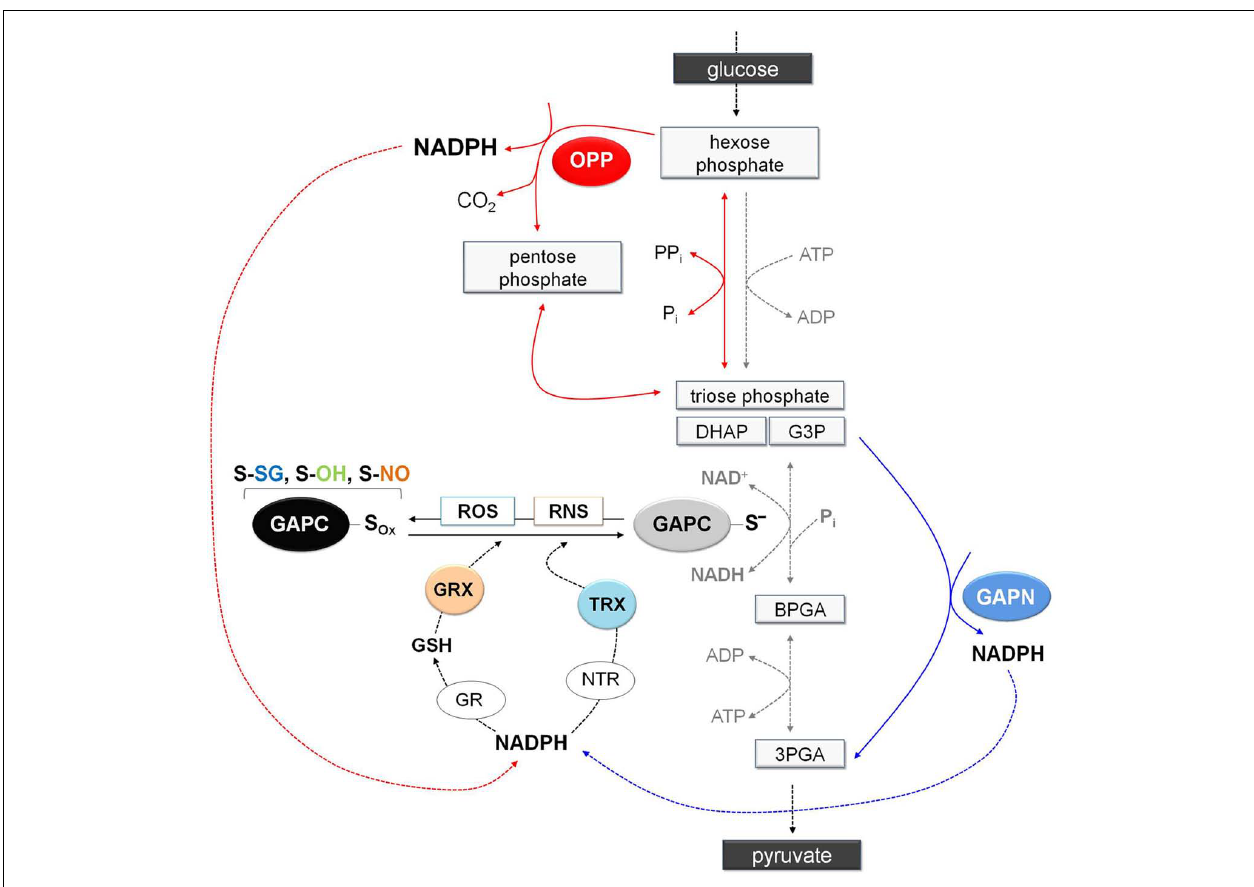
FIGURE 7 | Schematic representation of glycolysis showing the NADPH-producing systems in a situation of oxidative modification of GAPC. Under stress conditions, GAPC might undergo different type of oxidative modifications (GAPC-S ox : sulfenation, S-OH; glutathionylation, S-SG; or nitrosylation, S-NO) with important effects on cytoplasmic primary metabolism. Indeed, inhibition of GAPC activity and the consequent down-regulation of glycolysis pathway would promote entry of glucose equivalents into the OPP pathway leading to the generation of NADPH (red arrows). Although inhibition of GAPC would down-regulate the glycolytic pathway, plant cells also contain a non-phosphorylating GAPDH (GAPN) that can by-pass the GAPC-catalyzed reaction providing an alternative source of NADPH for the antioxidant enzymes (blue arrows). Glutathione reductase and